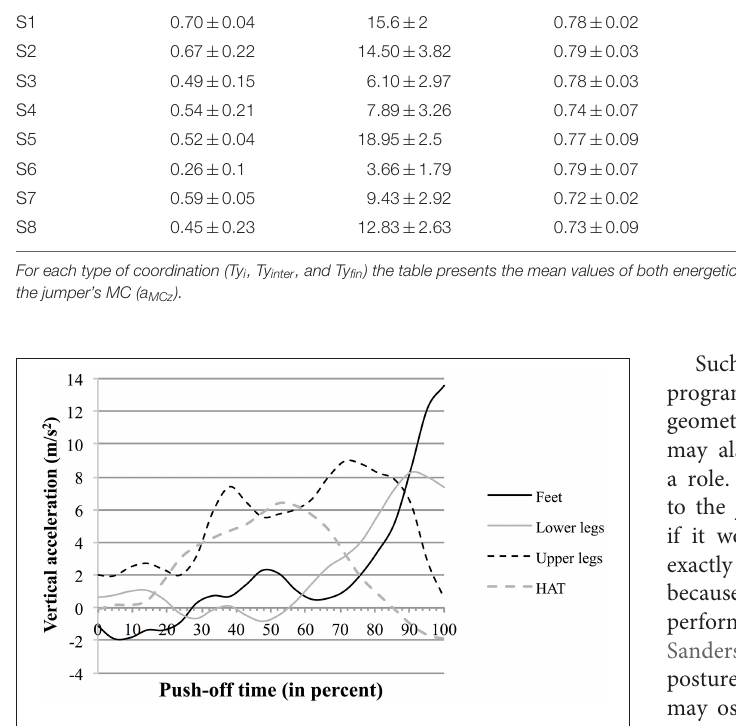
FIGURE 8 | Vertical acceleration of a jumper’s segments as function of time during push-off : example of the jumper S6. The full and dotted black lines, and the full and dotted gray lines represent the curves as function of time (percent of the push-off phase time length) of the vertical acceleration of the jumper’s feet, upper legs, lower legs, and HAT,